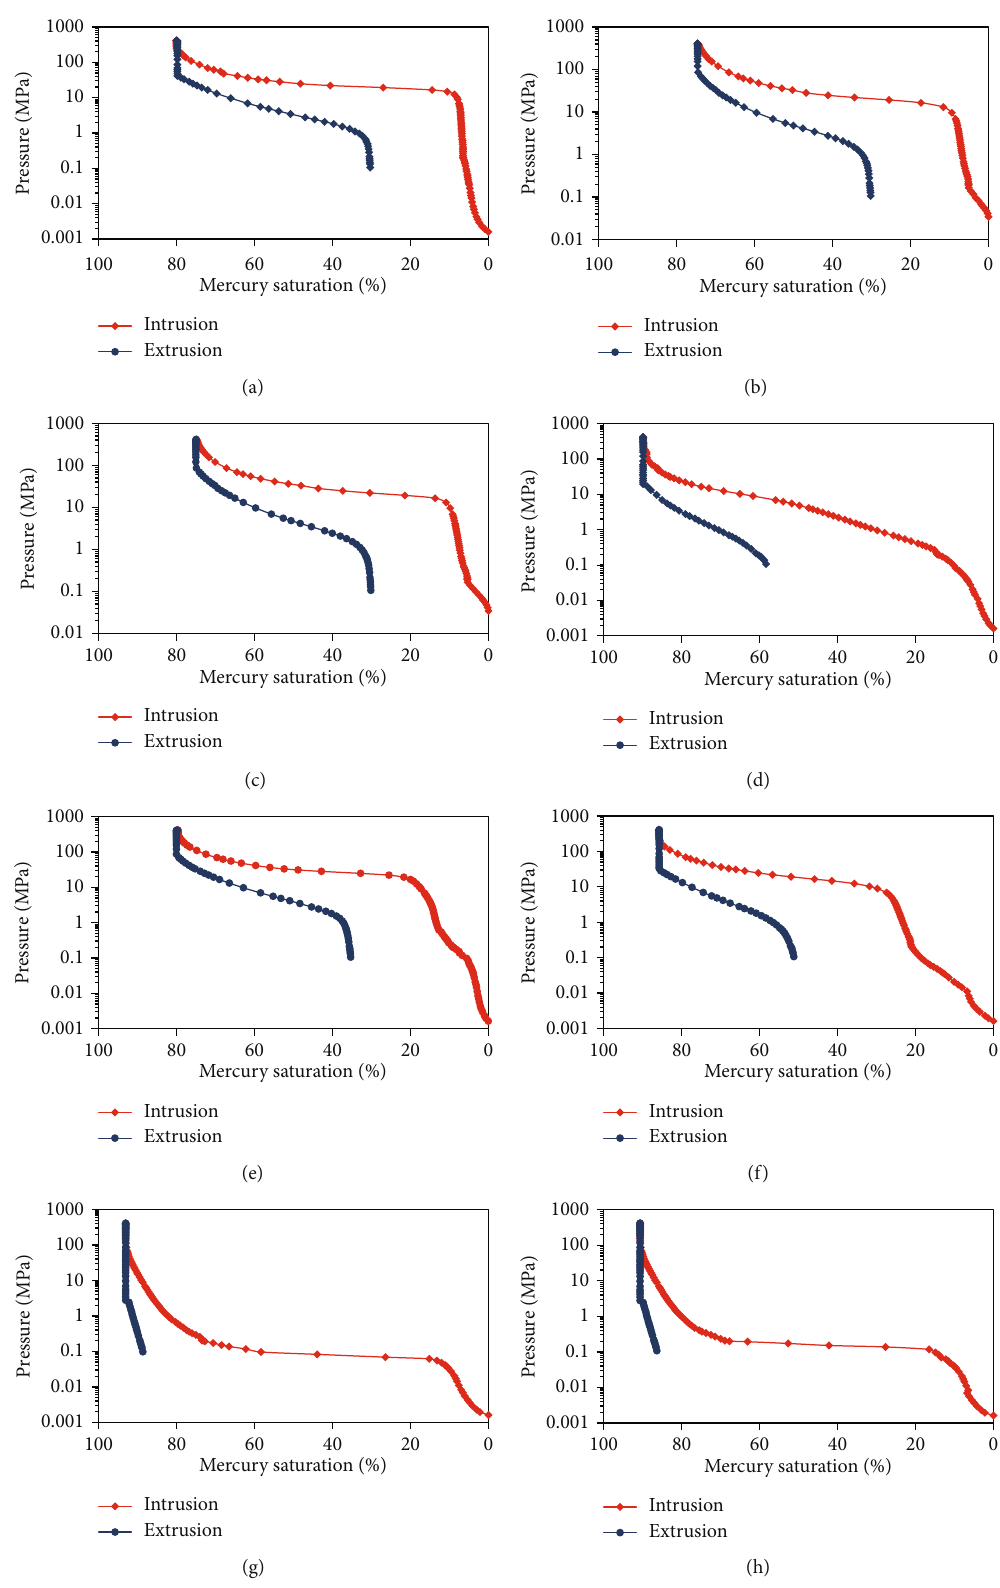
Figure 7: Capillary force curves of di ff erent mudstone samples. (a) H-1: pure mudstone; (b) H-2: pure mudstone; (c) H-3: pure mudstone; (d) H-4: silty mudstone; (e) H-5: silty mudstone; (f) H-6: silty mudstone; (g) H-7: sandy mudstone; (h) H-8: sandy